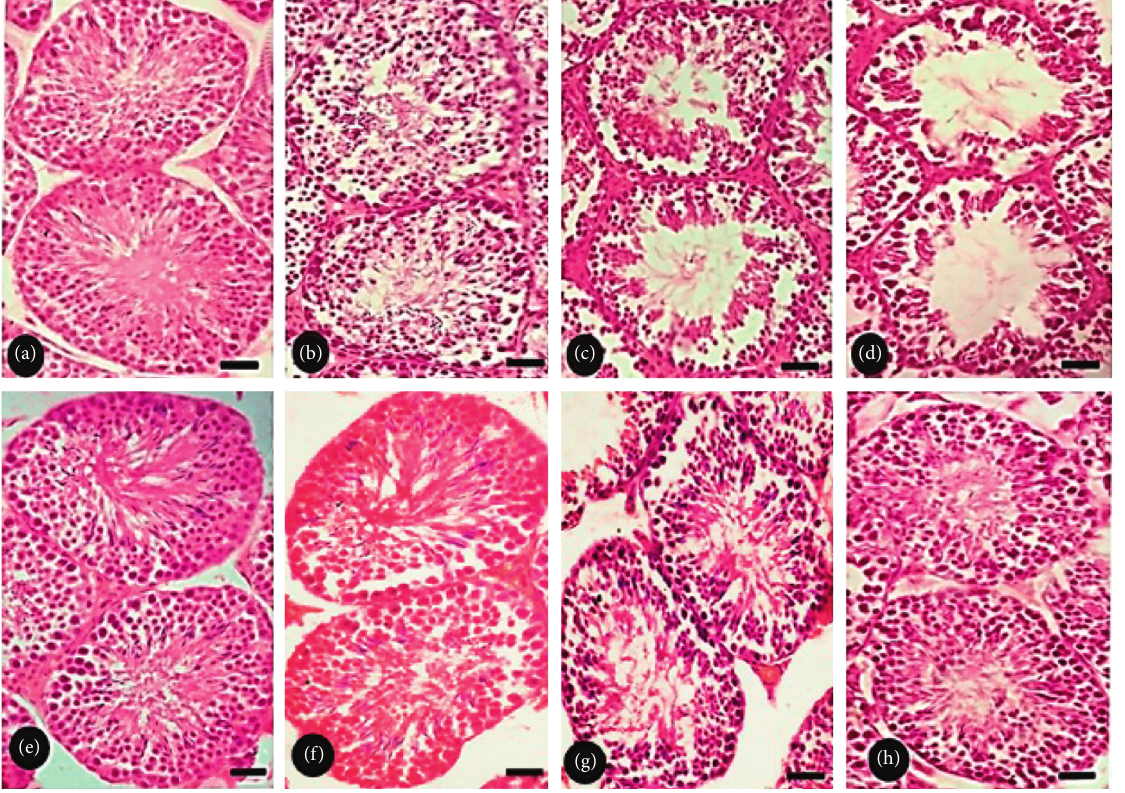
Figure 6: Transverse section of testes exposed to baicalein (BC) without or with testosterone (T) injection. Scale bar � 50 μ m. (a), (e) Testis of control mice showing the presence of normal tubular structure with spermatogenic cells at different stages of development. (b) Testis of F1 mice exposed to 30 mg · BC/kg body weight (BW) showing the wide lumen with a less number of sperm and spermatogenic cells. (c) Testis of F1 mice exposed to 60mg · BC/kg BW showing wide intratubular space with a less number of sperm in the lumen. (d) Testis of F1 mice exposed to 90mg · BC/kg BW showing large lumen devoid of sperm. (f), (g), and (h) Testis of F1 mice injected with 4.19mg · T/kg BW to 30, 60, and 90mg · BC/kg BW, respectively, showing seminiferous tubules filled with